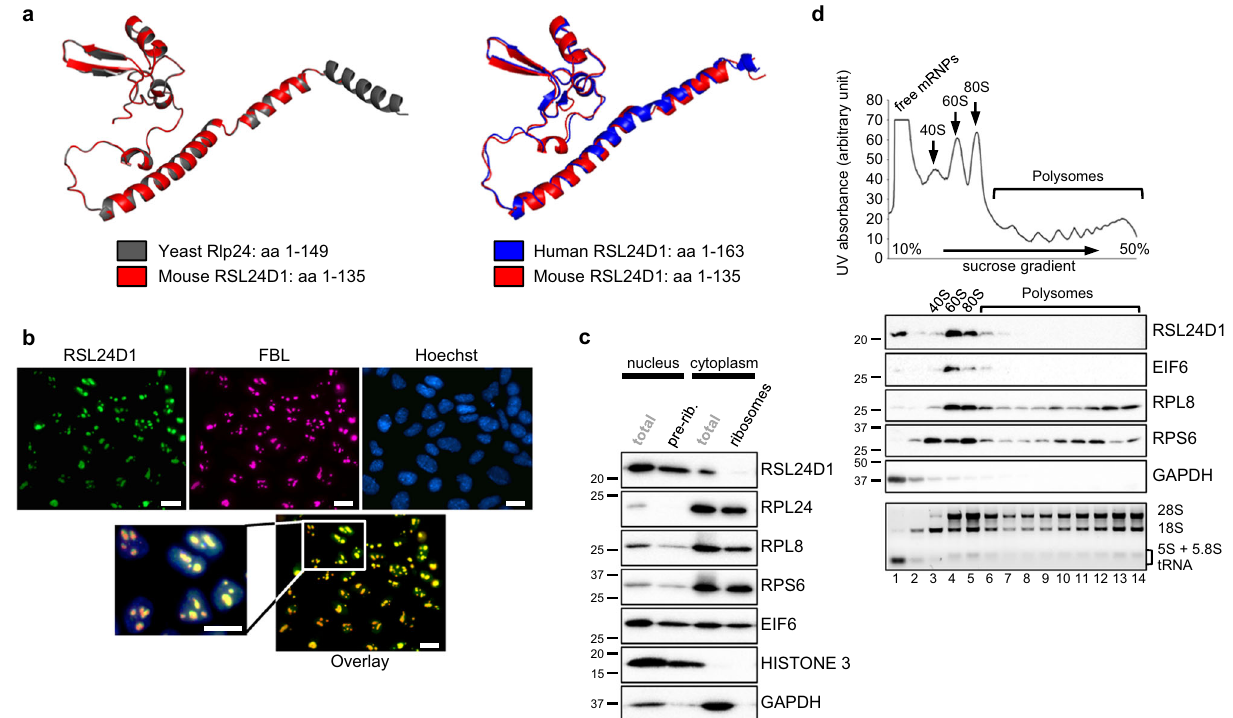
Fig. 2 | RSL24D1 is associated with pre-60S subunits in mouse ESCs. a Comparison of the mouse RSL24D1 predicted structure (amino acids 1 – 135, red color)withtheyeastRlp24structure(aminoacids1 – 149,graycolor,leftpanel)and the human RSL24D1 structure (amino acids 1 – 163, blue color, right panel) 33,34 . The mouse RSL24D1 protein structure was predicted from the 6N8J and 6LSS PDB structures using the swiss-model structure assessment tool 69 . b Representative images of naive CGR8 cells stained with Hoechst and with anti-FBL and anti- RSL24D1 antibodies (20× objective) ( n =3). The scale bar represents 10 μ m. c Representative immunoblots of ESC FBS nucleo-cytoplasmic fractions before (total) and after sucrose cushion puri fi cations of nuclear pre-ribosomes (pre-rib.)